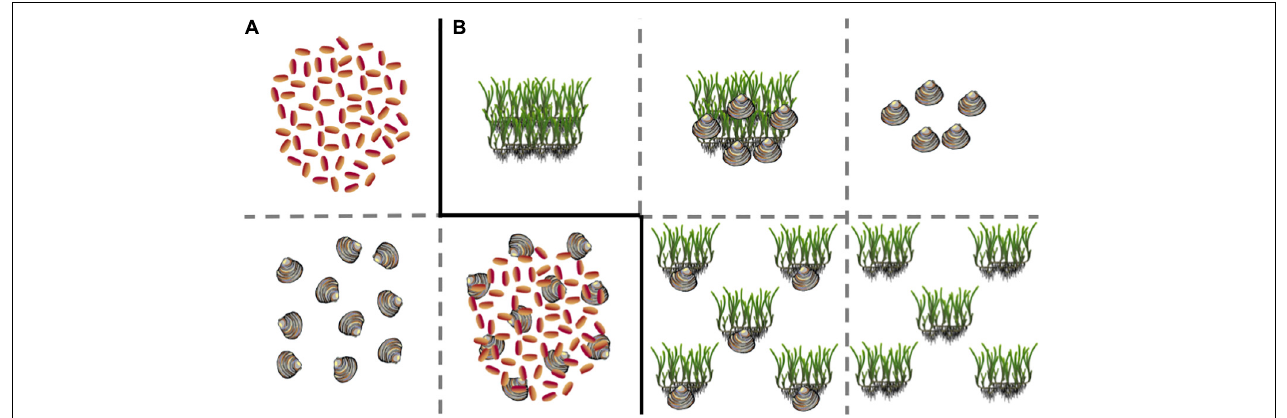
FIGURE 1 | Planting schematic of (A) seed and (B) adult shoot experiments. Solid black lines indicate different experiments. Each experiment also included a control bare plot not depicted here. Graphics courtesy of Abigail Poray, and Catherine Collier, Integration and Application Network, University of Maryland Center for Environmental